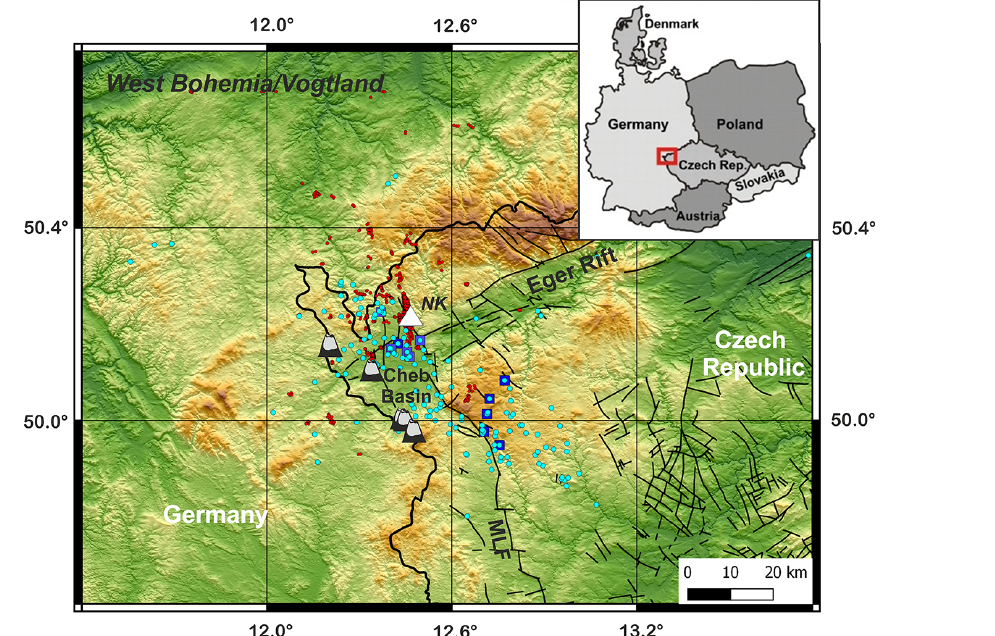
Figure 1. The West Bohemia–Vogtland geodynamic region in the westernmost part of the Eger Rift: the epicenters of earthquakes from 1991 to 2021 are marked by red circles; cyan circles represent CO 2 degassing; blue squares represent mofettes; the white triangle marks the Nový Kostel (NK) focal zone; the positions of five Quaternary volcanoes are